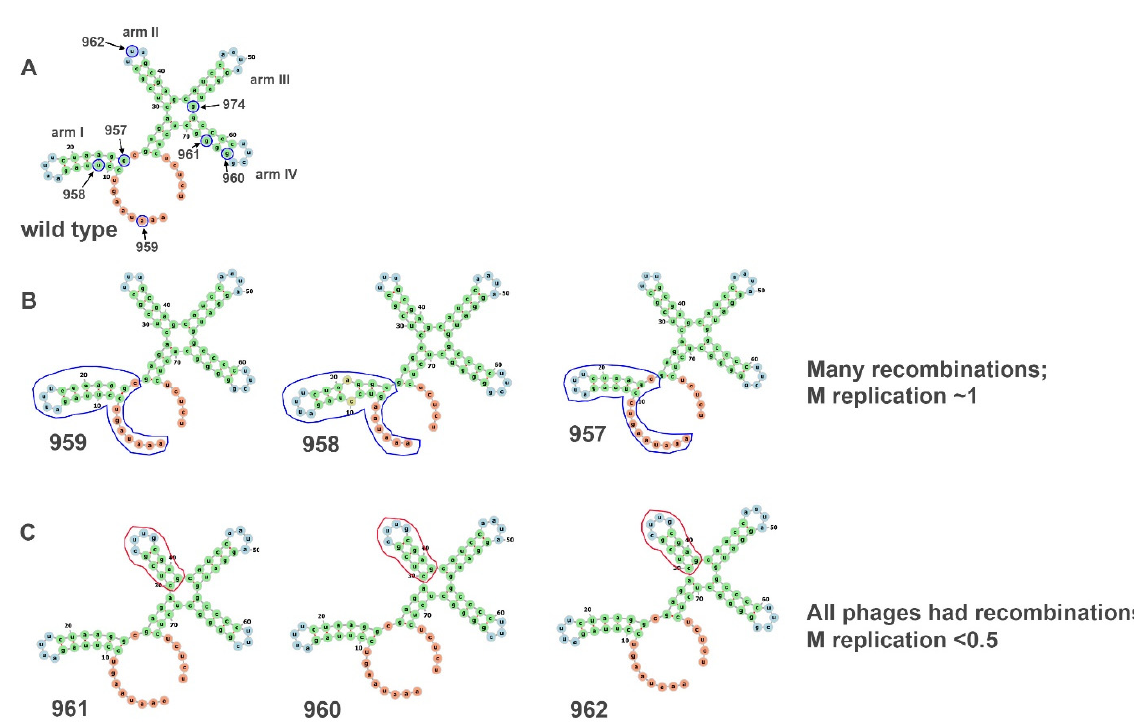
Figure 7. Alteration of the secondary structure of the 3 (cid:48) end of the M segment. Introduced deletions of the 3 (cid:48) end caused changes in the predicted secondary structure. The deleted nucleotides are encircled in blue in ( A ). ( B ) The blue outlined arm shows the difference in structure between the wildtype M segment and mutated ones. Changes in the blue outlined arms caused many recombinants in the M segments, but the replication rate of the M segment was nearly the same as of wildtype M. ( C ) The structure of the red outlined hairpin on these three mutants was different from the second arm in wildtype M. These mutations caused a significant reduction in M replication rate (<5), and all the produced phages were recombinant. Based on from Mindich et al. (1994). The secondary structure was calculated using the forna online RNA secondary structure visualization tool (http://rna.tbi.univie.ac.at/forna/, accessed on 17 August 2022) .